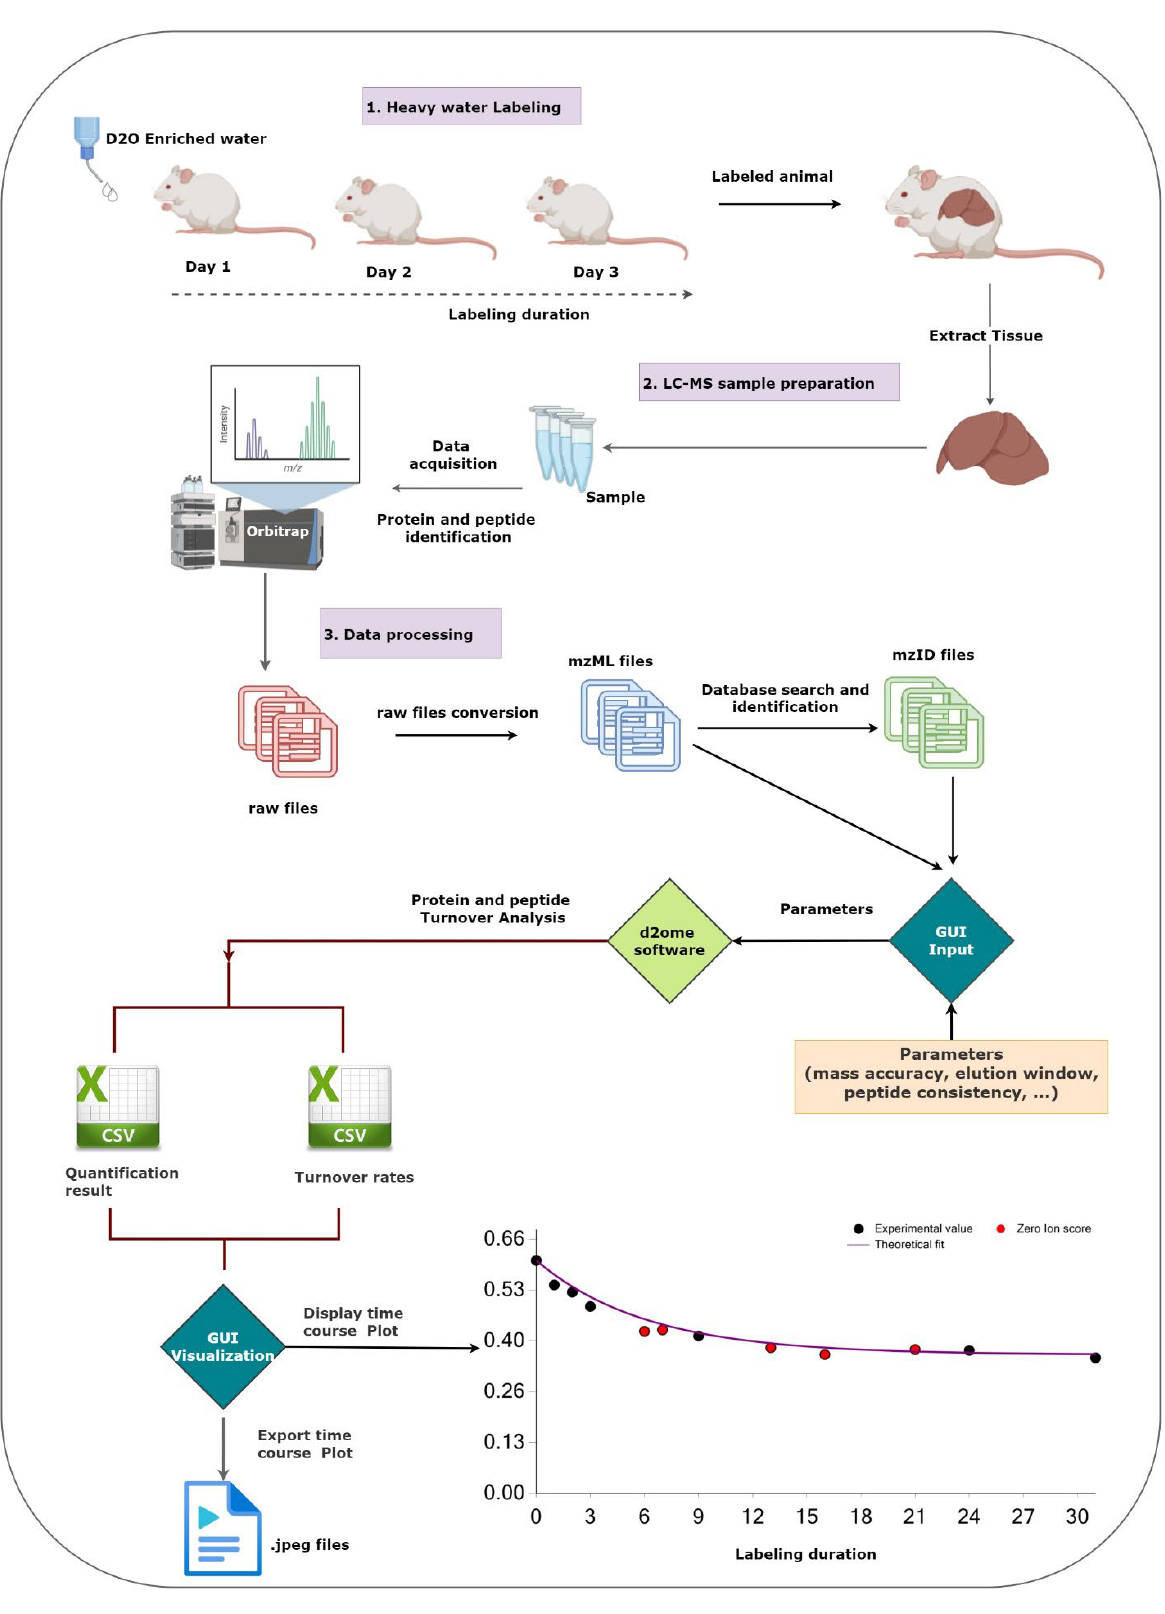
Figure 1. The figure shows the workflow of the main experimental and data processing of protein turnover studies and the role of the graphical user interface (GUI). The GUI aids in setting up the protein turnover rate estimations (creating input data from mzML and mzid files) and visualizing the results to facilitate the validations.